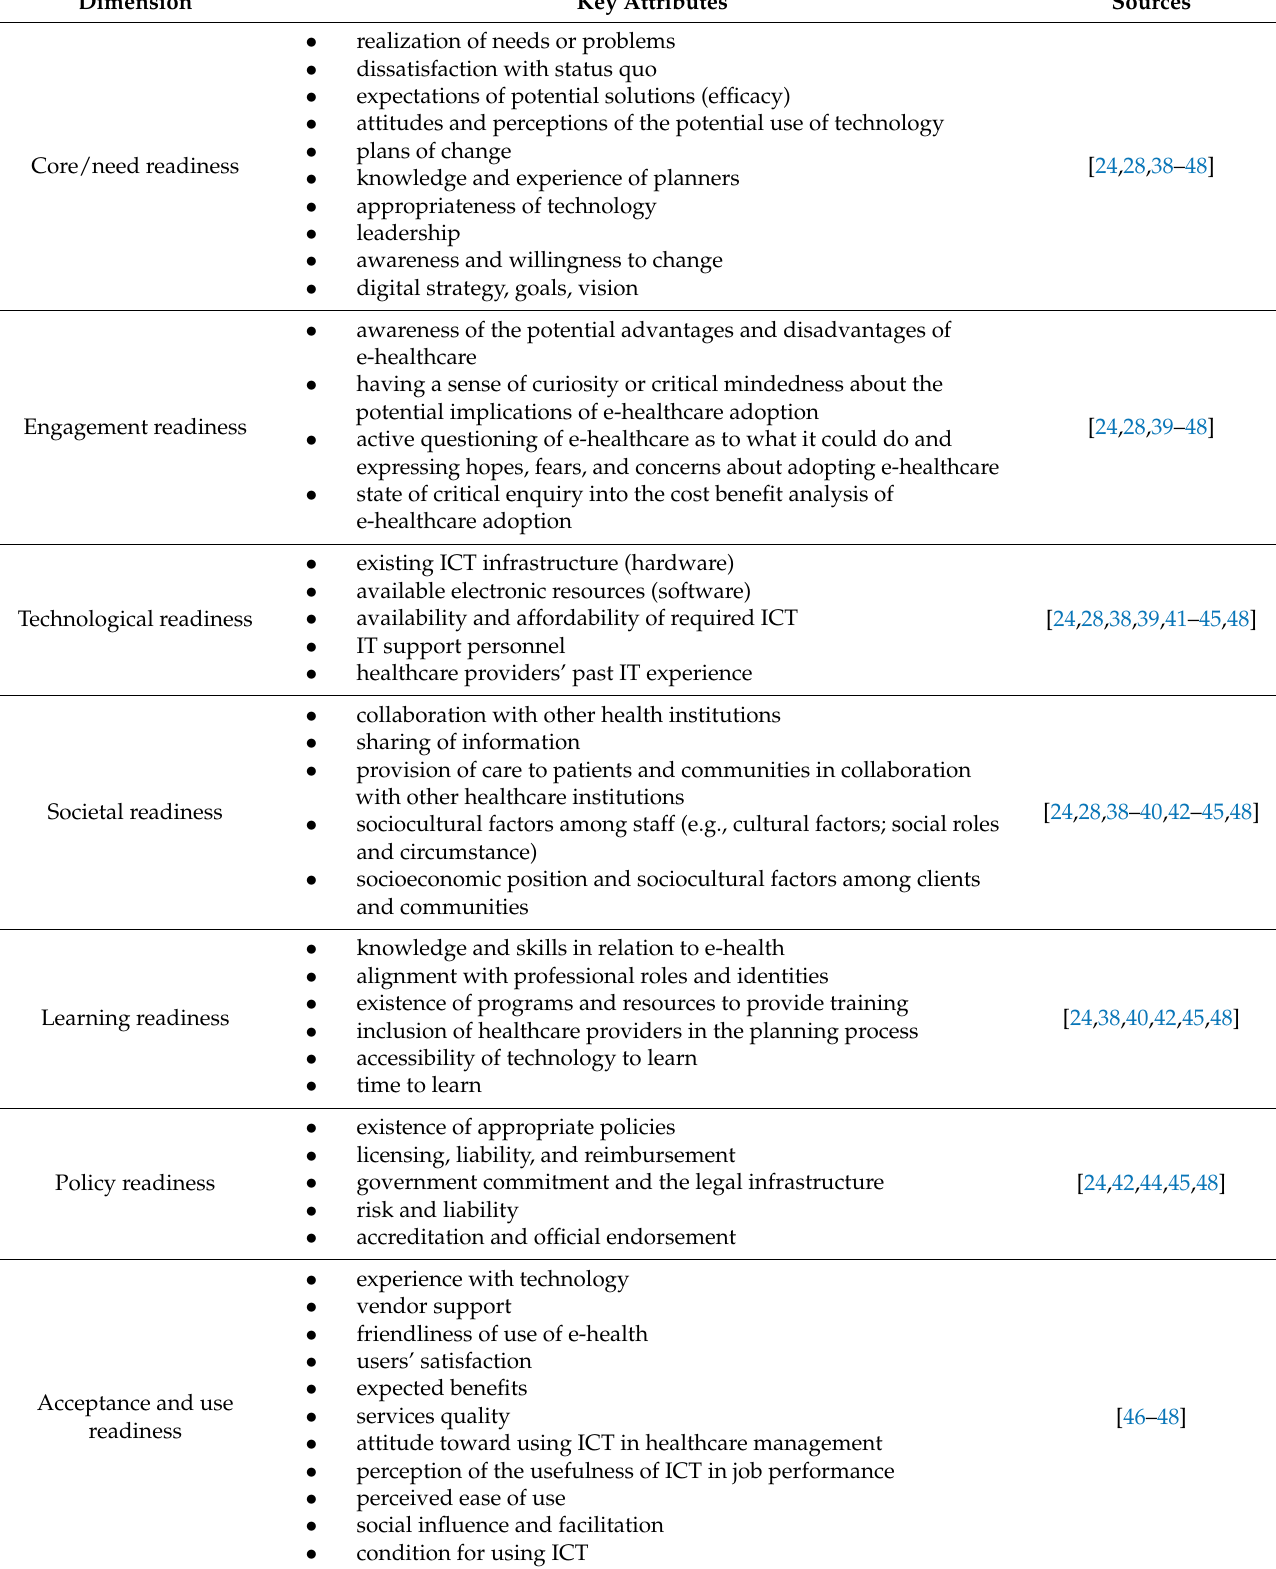
Table 1. e-Health readiness dimensions and their key attributes—literature review findings. Dimension Key Attributes